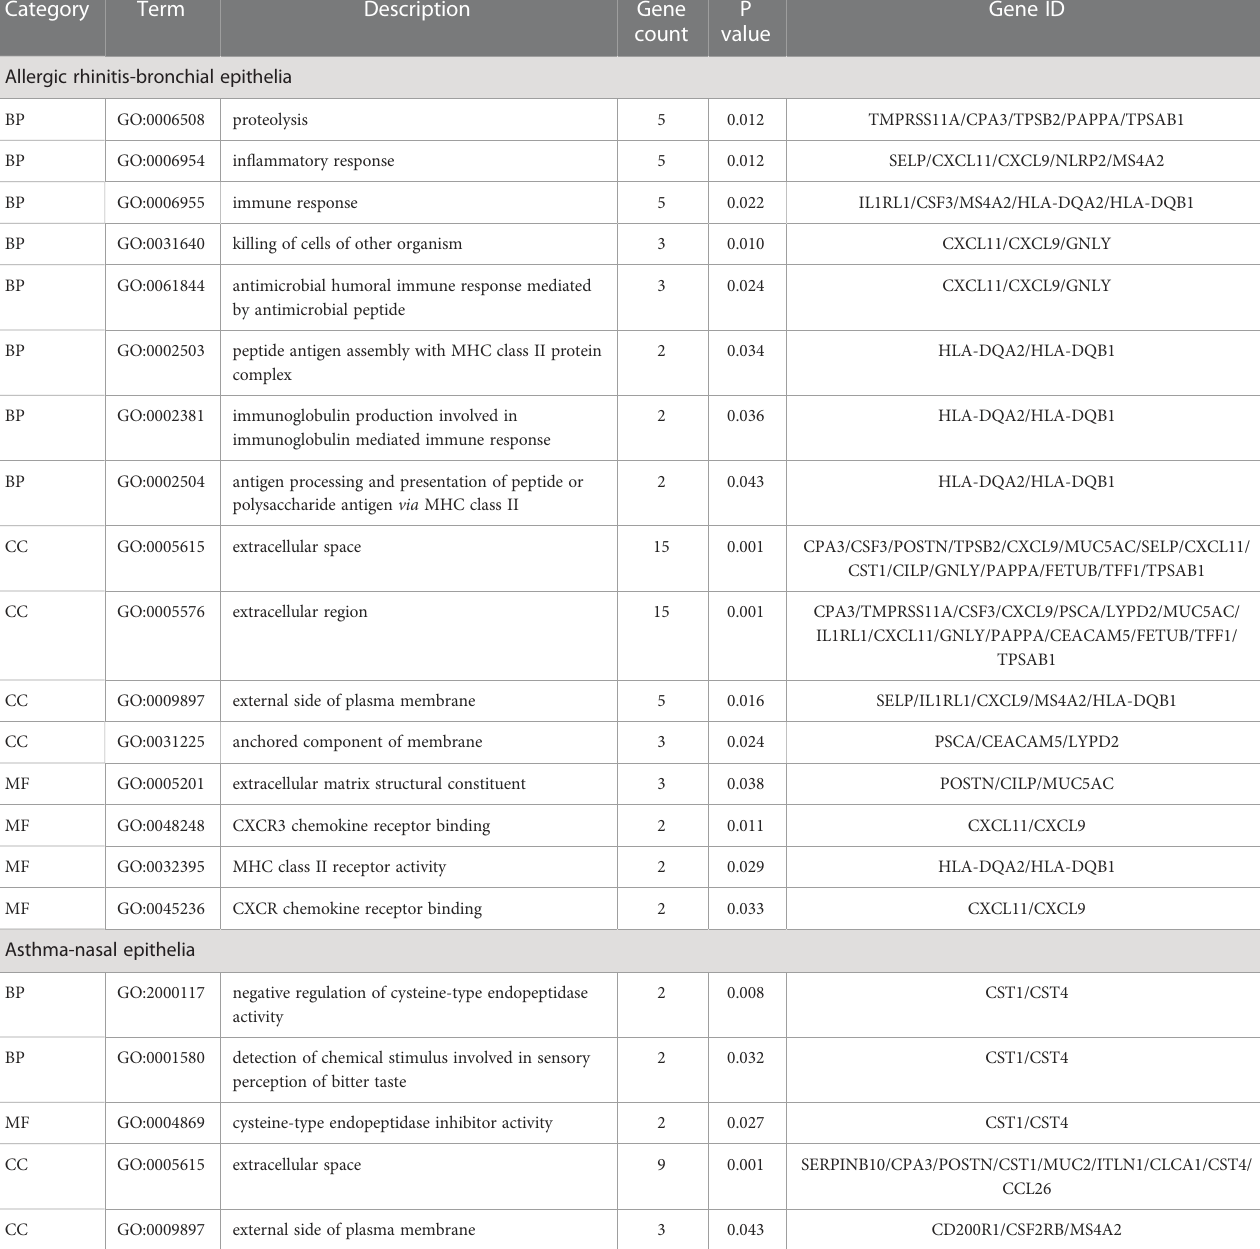
TABLE 4 Results from GO enrichment analysis of DEGs. Category Term